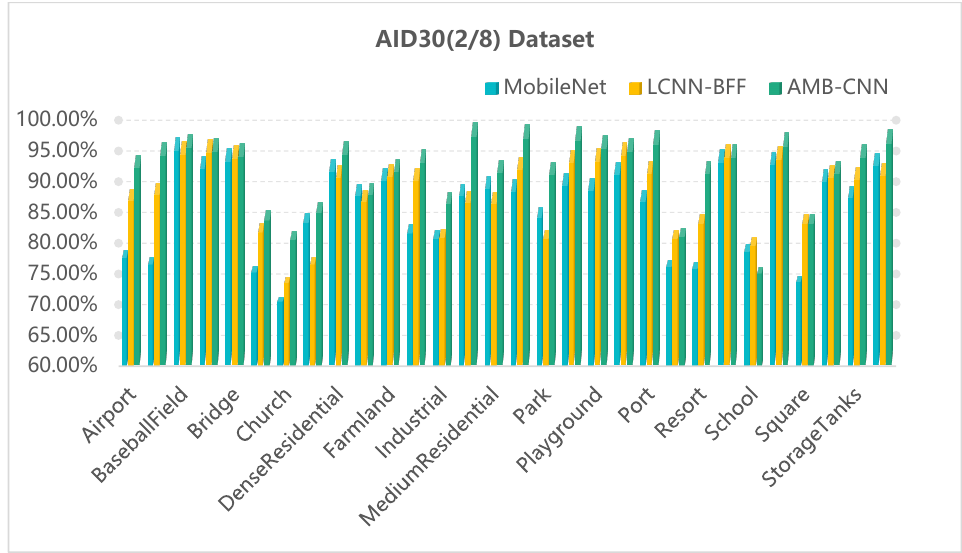
Figure 9. AP comparison results of the three methods for each category of the AID30 (2/8) dataset.